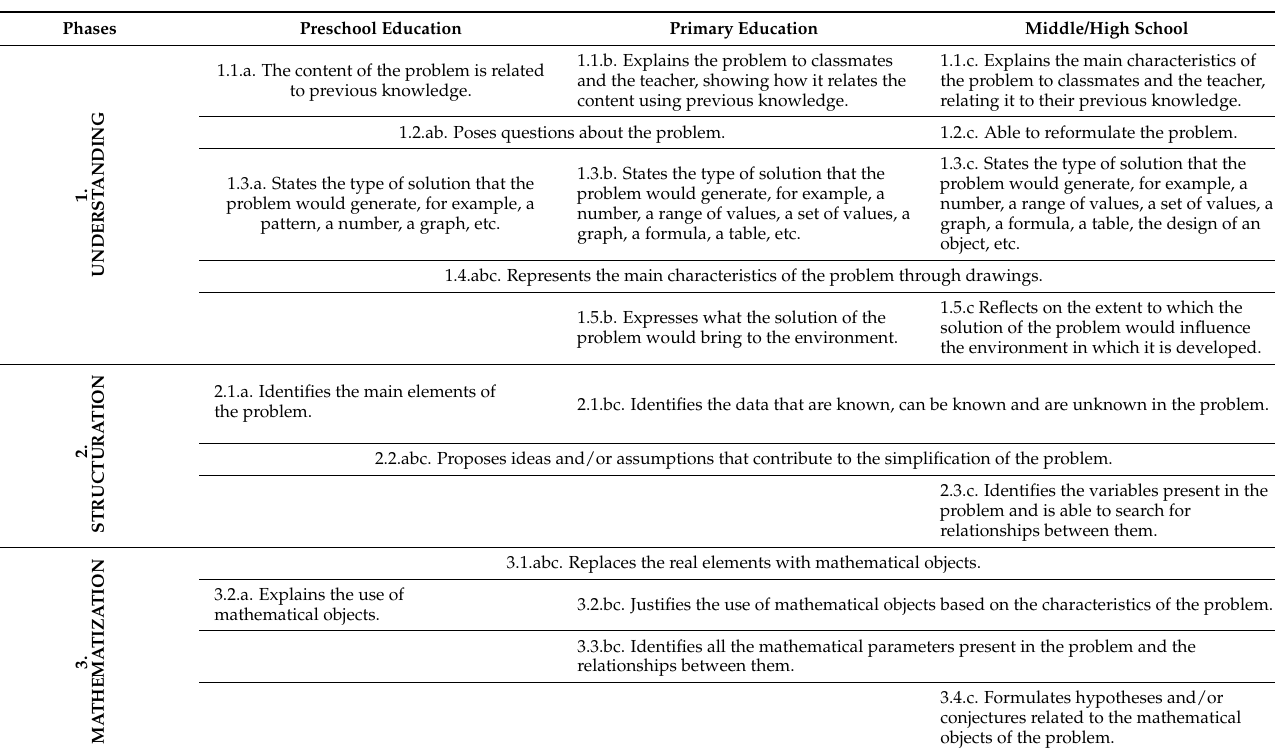
Table 8. Final version of the